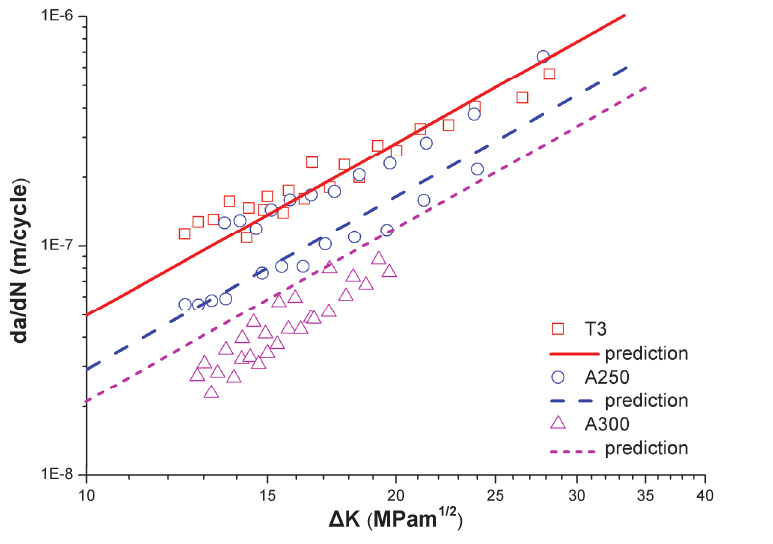
Figure 6: Experimental and computed fatigue crack growth rates vs. stress intensity factor range (d α /dN- ΔΚ ) in T3, A250 and A300 materials. The analytical results were obtained for c=-0.6 and r c =1.291x10 -6 m.